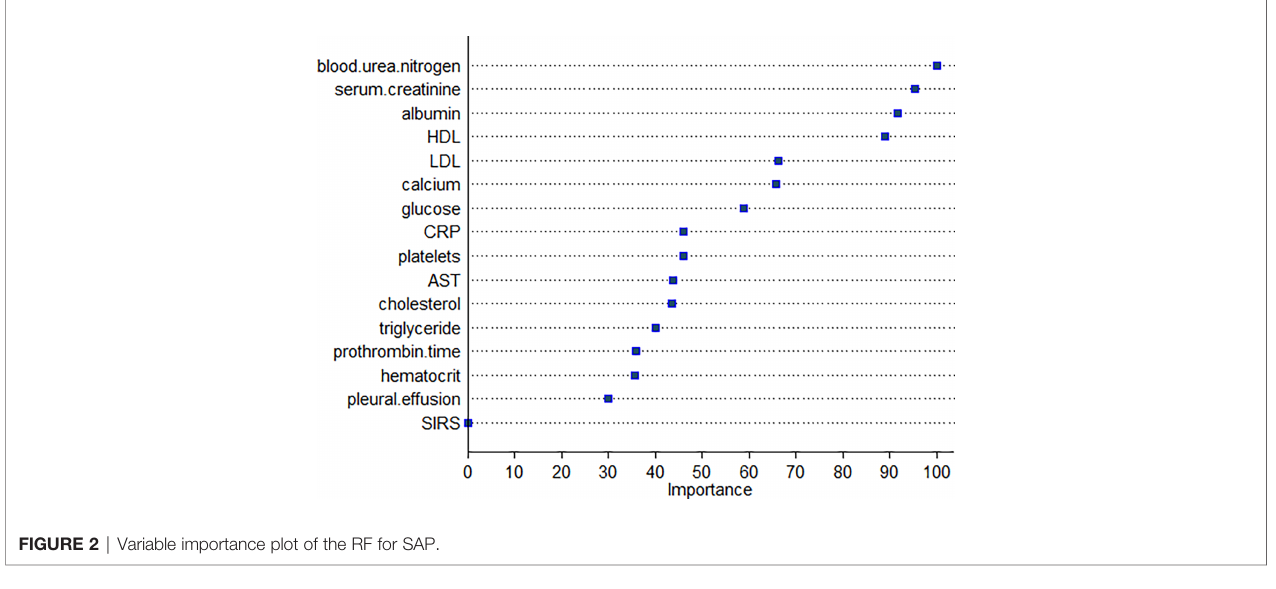
FIGURE 2 | Variable importance plot of the RF for